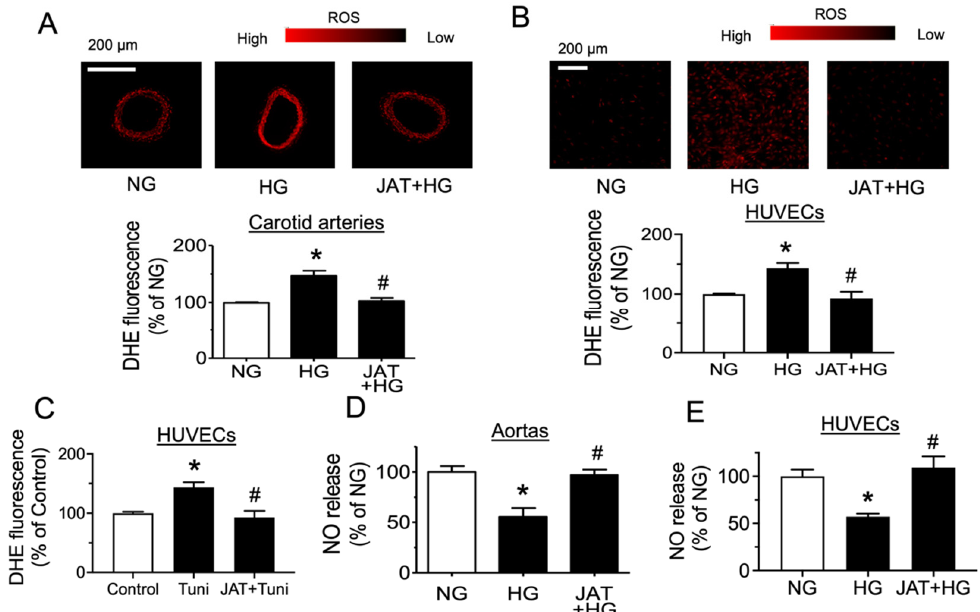
Figure 6. Jatrorrhizine suppresses oxidative stress and increases nitric oxide (NO) bioavailability. ( A , B ) Representative images and summarized data showing exposure to high glucose (30 mM, 48 h) increased the level of reactive oxygen species (ROS) in mouse carotid arteries and HUVECs, and such elevation was decreased by JAT at 1 μ M as measured by dihydroethidium (DHE) staining. ( C ) JAT (1 μ M) treatment inhibited the tunicamycin (tuni; 2 μ g/mL, 1 h)-triggered ROS generation in HUVECs. ( D , E ) NO release from mouse aortas and HUVECs upon high glucose (30 mM) stimulation and cotreatment with JAT (1 μ M) for 48 h as assessed by measuring the nitrite level in culture medium using Griess reagent. Results are mean ± SEM of 4-6 experiments. * p < 0.05 vs. NG or Control; # p < 0.05 vs. HG or Tuni.